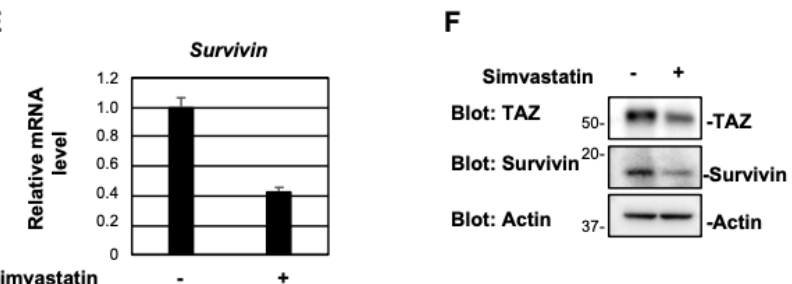
Figure 2. Simvastatin and fluvastatin suppress TAZ protein expression. ( A ) MCF7 and U2OS cells were treated with 10 µ M simvastatin for the indicated times. Cell lysates were immunoblotted with the indicated antibodies. ( B ) MCF7 cells were treated with 10 µ M fluvastatin for the indicated times. Cell lysates were then analyzed as in ( A ). ( C ) Cells were treated with 10 µ M simvastatin and the expression of each gene was assessed by RT-qPCR. The expression levels of TAZ were normalized against the expression level of β -actin mRNA. Results are shown as the mean ± S.D. ( n = 3). ( D ) MCF7 cells were transfected with control or TAZ siRNA. After 48 h, cell lysates were immunoblotted with the indicated antibodies. ( E ) MCF7 cells were treated with 10 µ M simvastatin and the expression of each gene was assessed by RT-qPCR. The expression levels of survivin were normalized using the expression level of β -actin mRNA. Data represent the mean ± S.D. ( n = 3). ( F ) MCF7 cells were treated with 10 µ M simvastatin for 24 h. Cell lysates were then analyzed by Western blotting with the indicated antibodies. Significant differences are indicated as ** p < 0.01. n.s., not